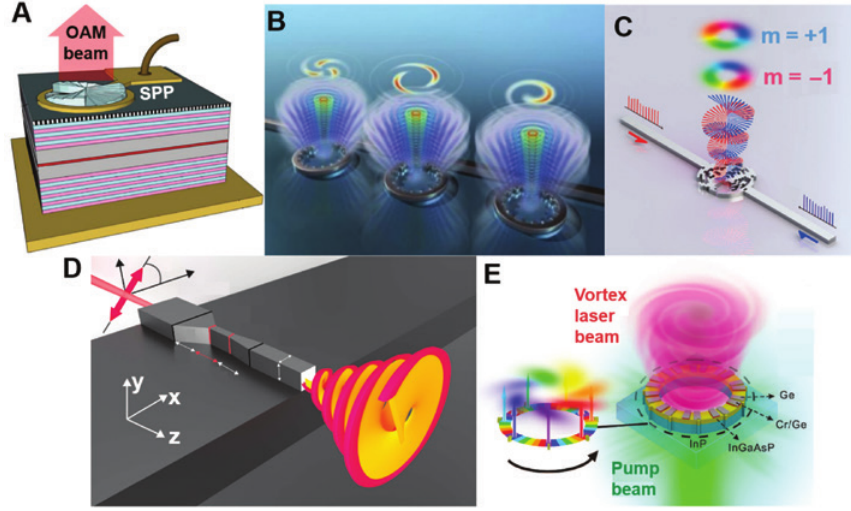
Figure 9: Micro-vortex lasing on chip. (A) Schematic of the vertical-cavity surface-emitting laser with an integrated spiral phase plate at the output port. Reprinted from